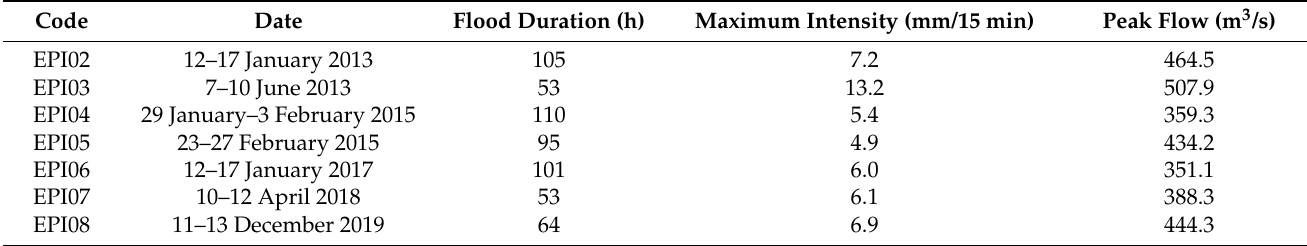
Table 4. Summary of the flood events considered in the calibration process of the Real-time Interactive Basin Simulator (RIBS) model. Maximum intensity refers to the mean rainfall intensity in the catchment. Code